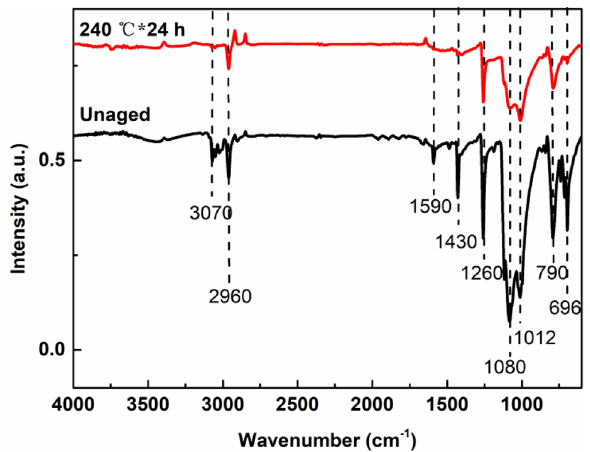
Figure 4. ATR-FTIR spectra of the MVPQ/CIPs/GR composites before and after thermal ageing at 240 °C for 24 h.